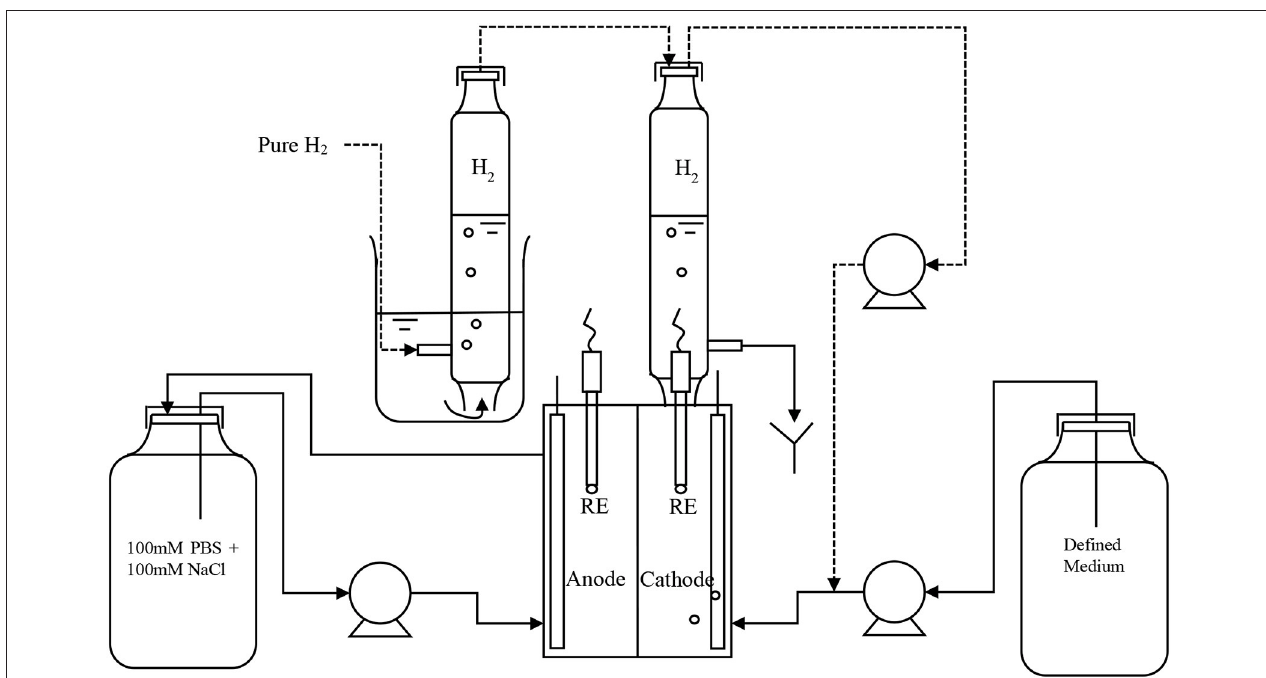
FIGURE 1 | Schematic of the experimental setup.